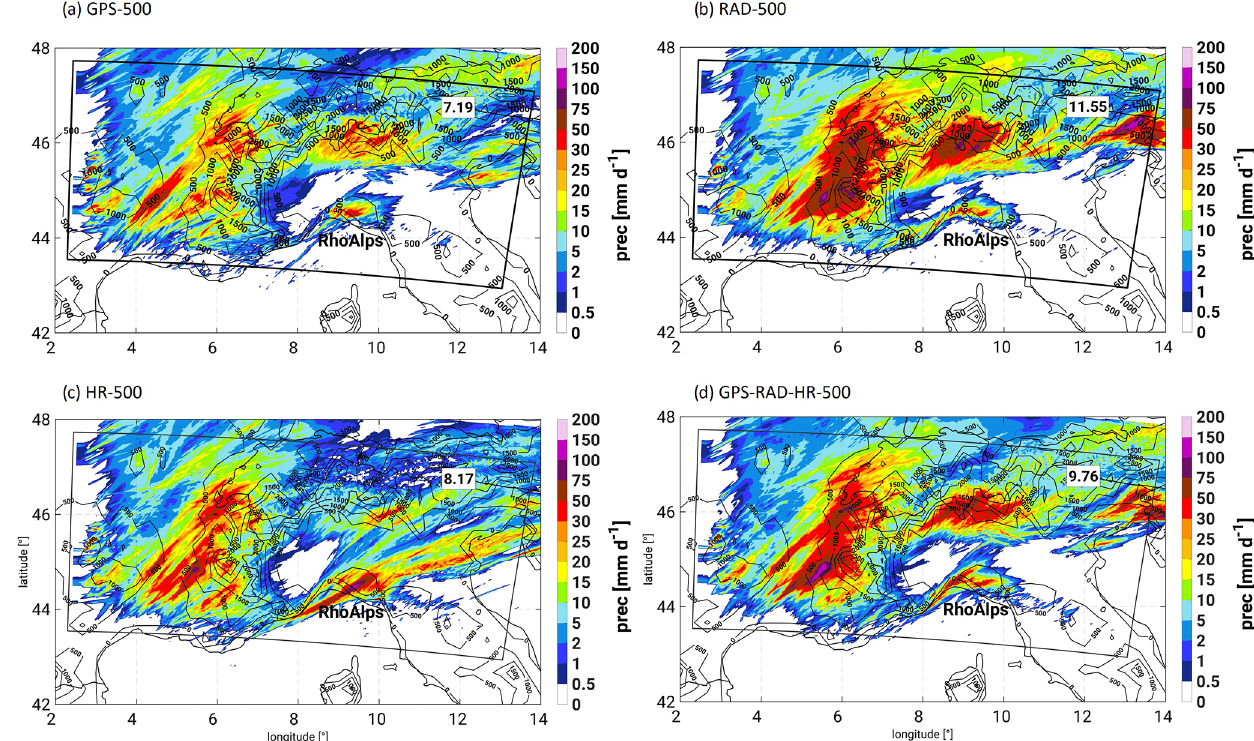
Figure 4. As Fig. 3 but for GPS-500 (a) , RAD-500 (b) , HR-500 (c) , and GPS–RAD–HR-500 (d) . The analogous analyses using the 7 and 2.8km grids are shown in the